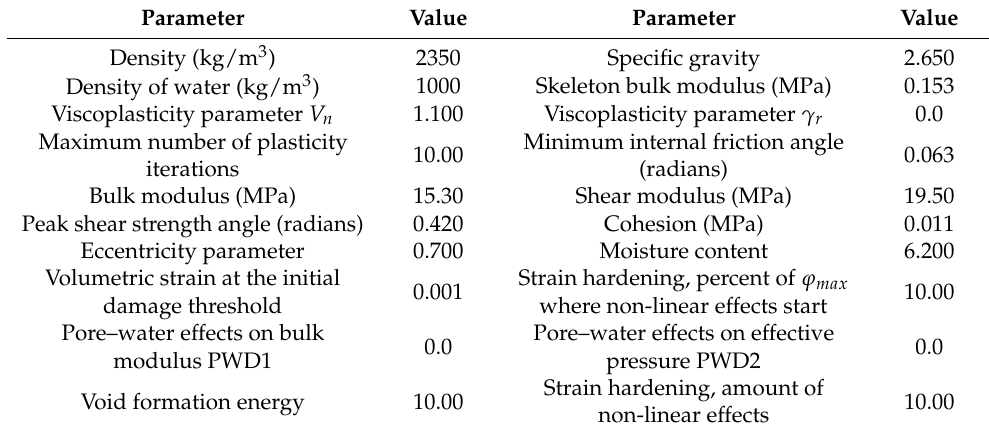
Table 3. Input parameters of the FHWA_SOIL model.